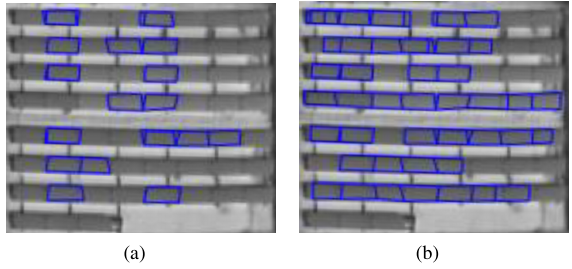
Figure 12. Iterative process of cell detection: a) Initial detection of cells where all four corners and the centre point have been de- tected. b) Final result of detected cells after the iteration process.